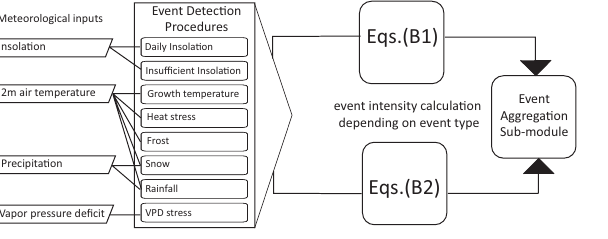
Fig. B1. How meteorological variables enter the EDPM framework.